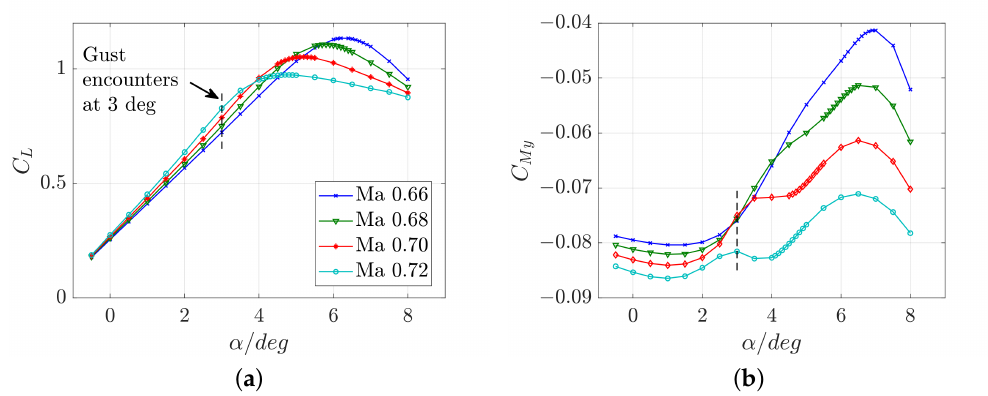
Figure 3. Steady polars for the RAE2822 airfoil. ( a ) Lift, ( b ) Pitching moment.